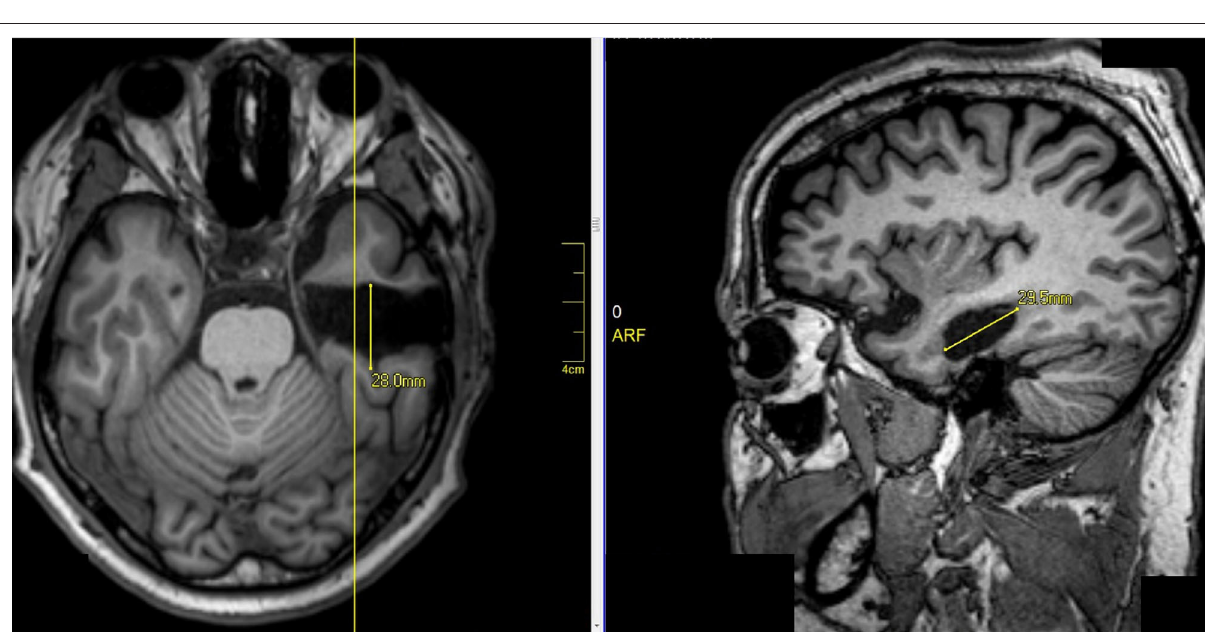
Binary logistic regression was performed to assess the impact of this set of independent (predictor) variables on the odds that patients would become seizure-free after surgery (the dependent variable). We included in the model the independent variables